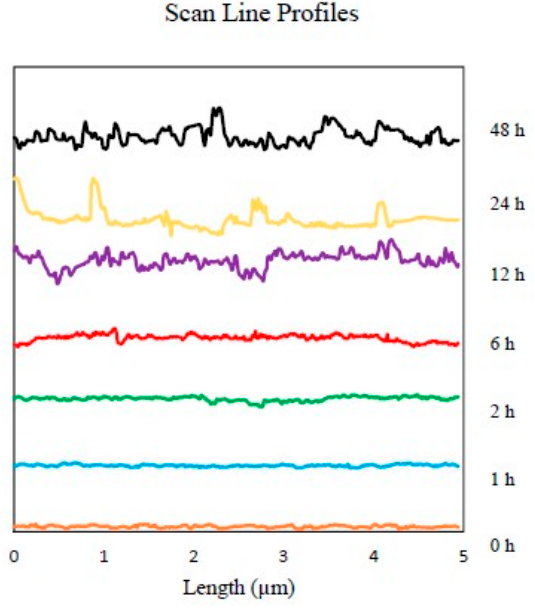
Figure 6. Various line scan profiles were obtained from the AFM’s measurement area. The separation distance between each line was applied to avoid overlaying.